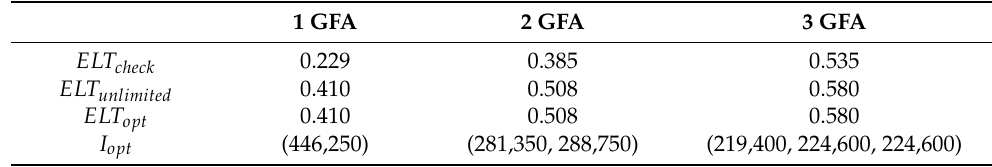
Table 6. The optimal inventory of backup